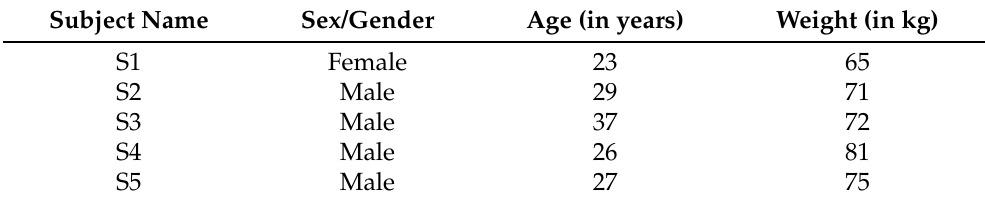
Table A2. Demographic data of subjects used for data acquisition in this